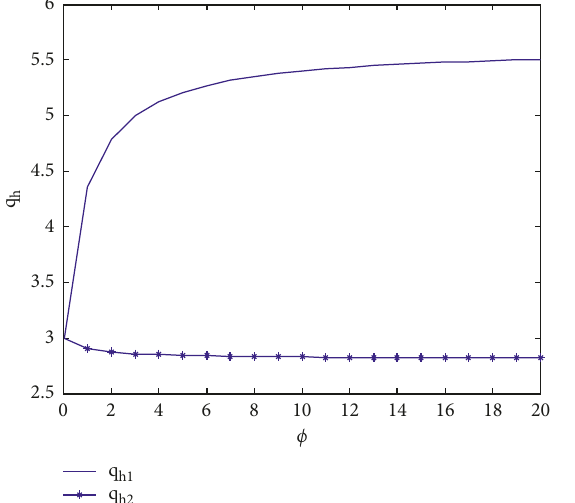
Figure 5: Impacts of horizontal fairness concern on ordering quantity.